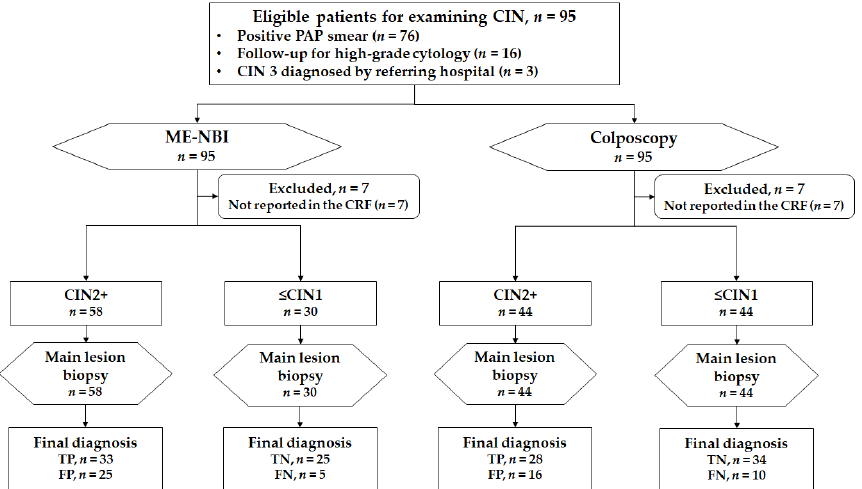
Figure 6. A STARD flow chart for a key secondary analysis: diagnostic ability for histological CIN2+ lesions. TP, true positive; TN, true negative; FP, false positive; FN, false negative. No serious (≥Grade 2 in CTCAE ver. 5.0) adverse even ts were observed. Among pa-